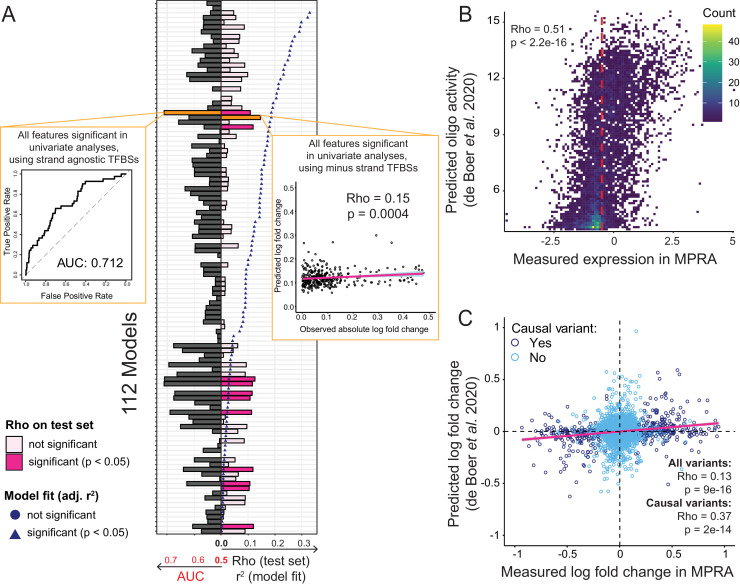
Prediction of causal variants and variant effects.(A) Prediction results for 112 models. On the left, the plot shows the performance of binomial classifiers on the 10% test as black bars. On the right, the plot shows the performance of the linear predictors of variant effects as spearman correlation coefficients (rho) between actual and predicted log-fold changes in expression as pink bars. Blue symbols show r2 values for each model when fit to the entire dataset. The best classifier and linear model are indicated by orange bars and shown as insets. (B) Measured expression driven by each oligo versus expression predicted by the de Boer model. The dashed red line denotes the median measured expression level. (C) Observed fold-changes of individual variants measured in our MPRA versus fold-changes predicted by the de Boer model. The pink line shows the linear regression fit for all variants.Figure 6—source data 1.Multiple-feature regression analyses of causal variants.Logistic and linear regression (to predict log-fold change) are in separate worksheets.